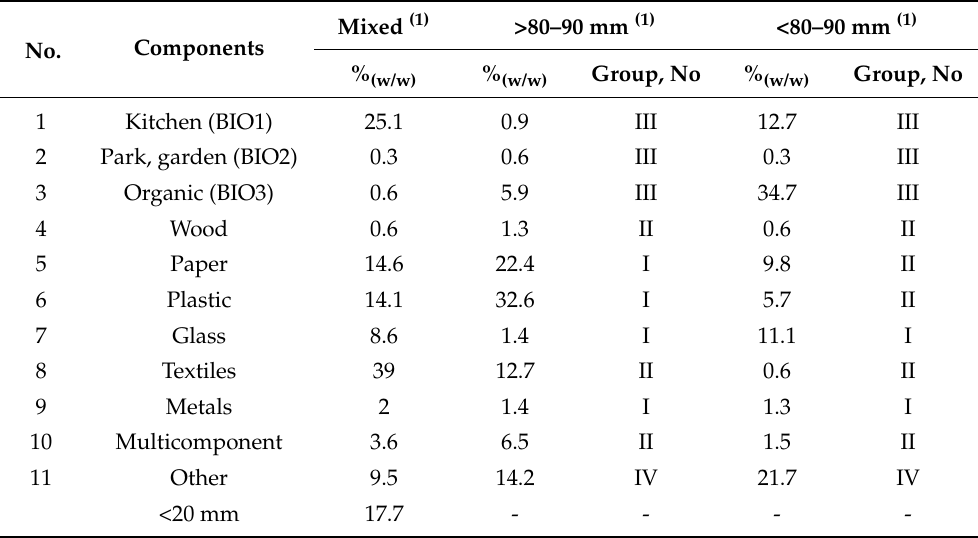
Table 1. Percentage shares of waste components and classification into four different